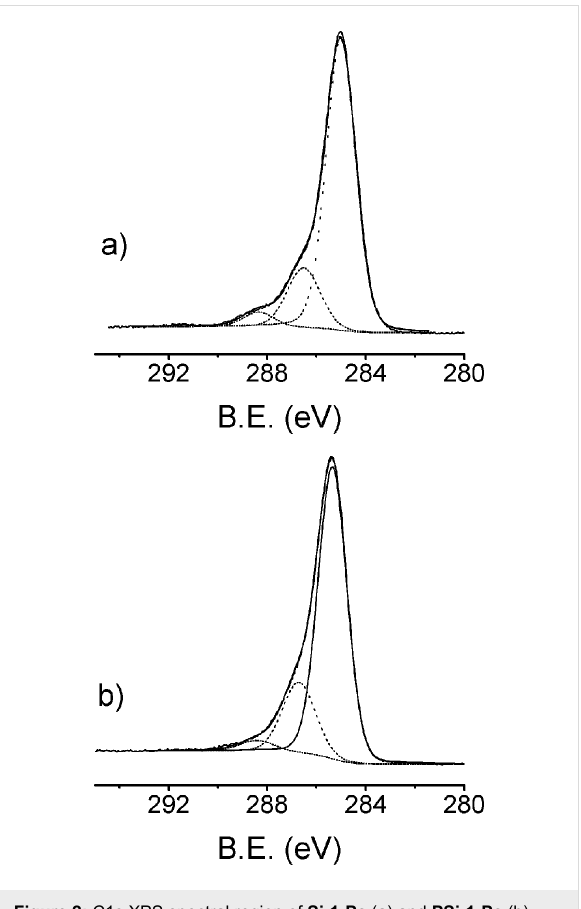
The N 1s XPS spectral regions of Si-1-Pc and PSi-1-Pc are reported in Figure 3a and 3b, respectively. The spectrum collected from Si-1-Pc shows two bands, at B.E. values of 398.8 and 400.4 eV. The first signal is due to non-protonated pyrrolic nitrogen atoms and due to iminic bridges, whilst the high B.E. signal is due to protonated pyrrolic nitrogen atoms [28-30]. However the intensity ratio between the 398.8 and 400.6 eV bands is 2:3, which is significantly different from the value (3:1) expected for free-base phthalocyanines [28-30]. The increase of the high B.E signal can be explained as a conse- quence of the interaction with the silicon surface. The effects